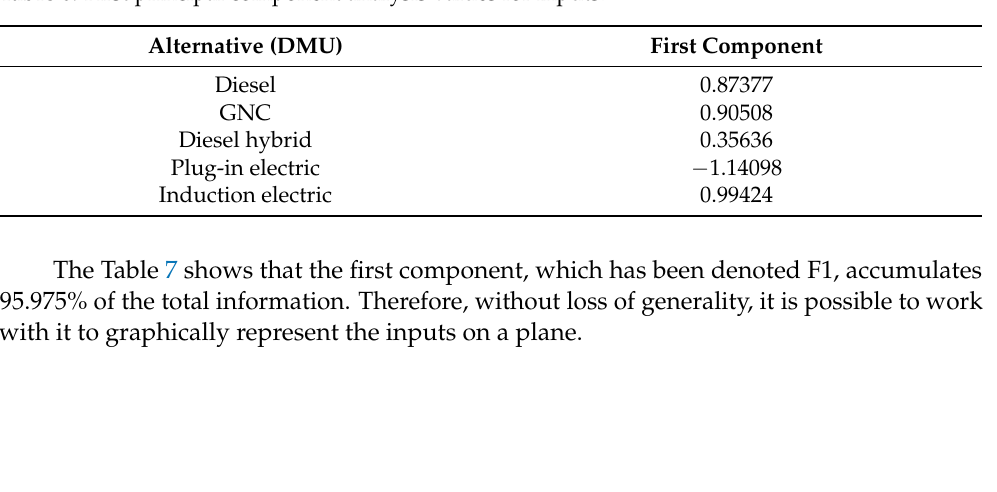
Table 6. First principal component analysis values for